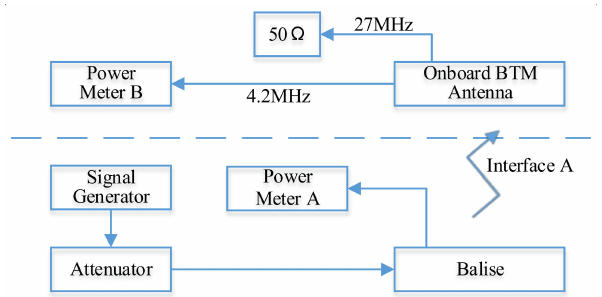
Figure 14. Uplink field conformity test configuration.